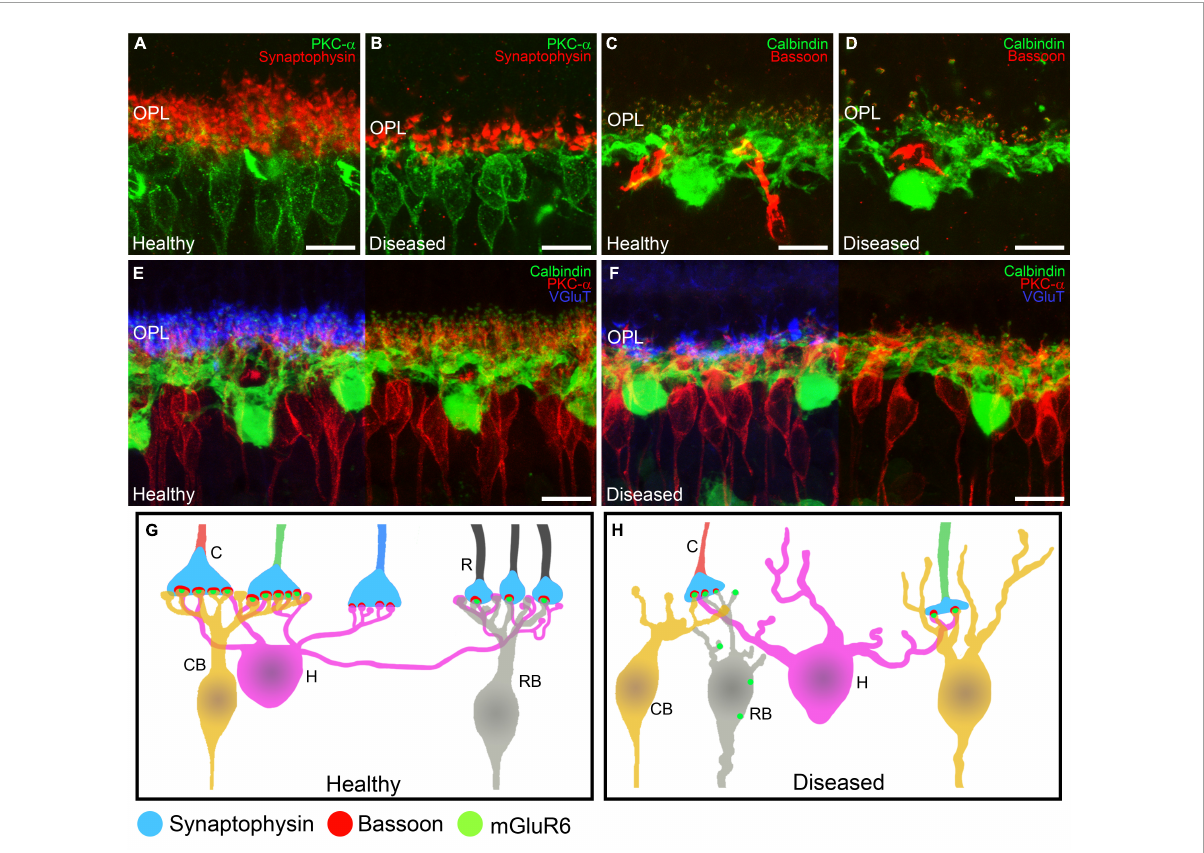
FIGURE5 Alterations in retinal cell connectivity in IRDs. (A–F) Retinal cross-sections immunostained with different retinal cell markers in a healthy mouse retina and in a retina from an IRD model. (A,B) Shows the dendrites of ON rod bipolar cells (PKC α , green) making contacts with photoreceptor axon terminals (synaptophysin, red). (A) Average synaptic contact density and morphology of rod bipolar cell dendrites in the OPL in healthy retinas. (B) Degeneration of ON rod bipolar cell dendrites and loss of photoreceptor synaptic terminals in IRDs retinas. (C,D) Horizontal cells (calbindin, green) being part of the ribbon synapse (Bassoon, red) along with photoreceptors. (C) Average synaptic contact density and morphology of horizontal cell dendrites in healthy retinas. (D) Loss of horizontal cell dendrites and synaptic ribbons from photoreceptors in IRDs. (E,F) Horizontal cells (calbindin, green) and ON rod bipolar cells (PKC α , red) making synaptic contacts with axonic terminals from photoreceptors (VGluT, blue). (E) Average synaptic contact density and morphology of horizontal and ON rod bipolar cell dendrites in healthy retinas. (F) Dendritic loss of horizontal and ON rod bipolar cells and degeneration of synaptic connections with photoreceptor axonic terminals. (G,H) Schematic depiction of the normal synaptic connections from rods and cones to bipolar cells in the OPL. Synaptophysin is located in the presynaptic terminals from rods and cones. Bassoon is part of the synaptic ribbon and mGluR6 is localized in the synaptic tips of the bipolar cell dendrites. During synaptic remodeling induced by IRDs (B) there are alterations in the synaptic contacts from the OPL. Rod bipolar cells make contacts with cone terminals and mGluR6 is shown delocalized around the somas of bipolar cells. OPL: outer plexiform layer; C: cone; R: rod; CB: cone bipolar cell; H: horizontal cell; RB: rod bipolar cell. Scale bars: 10 µ